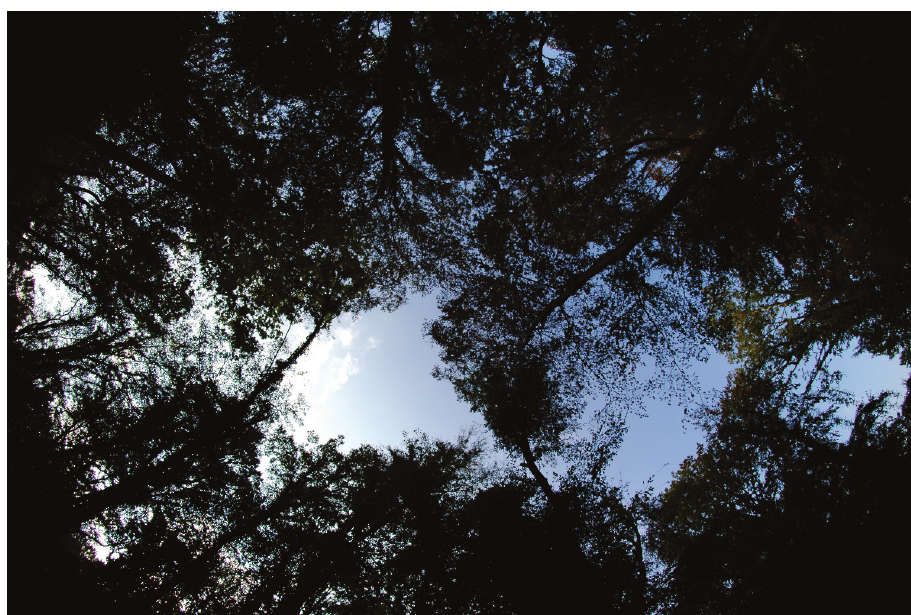
Figure 15. Canopy cover along a transect at Bosco della Fontana (photo by M. Bardiani, APS-C camera, 8 mm